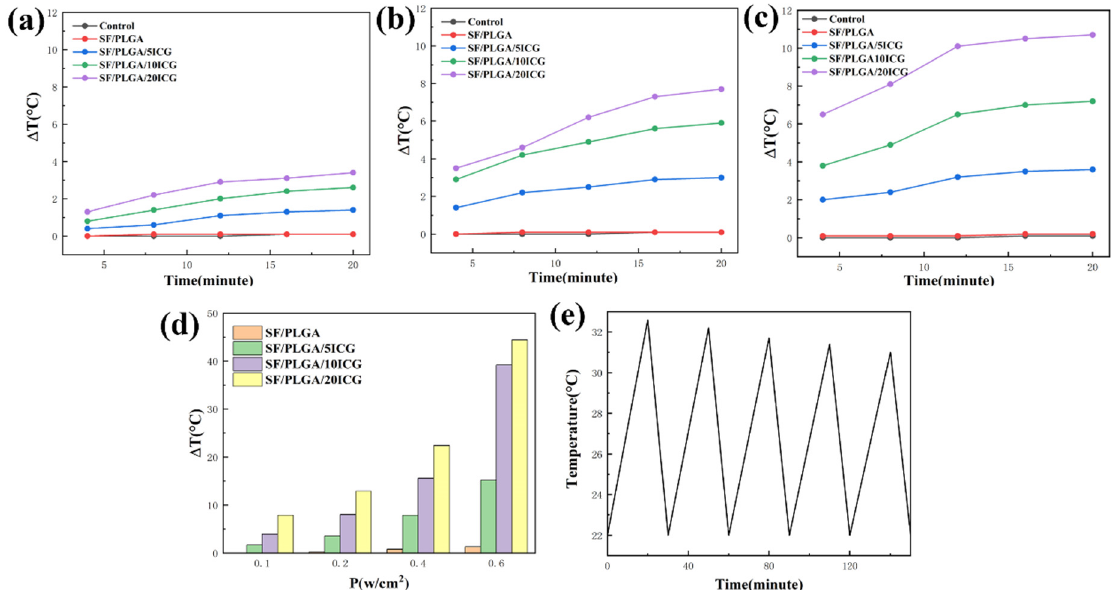
Figure 4. Photothermal performance. Temperature profiles of the nanofibrous membranes in PBS upon NIR irradiation of ( a ) 0.2 w/cm 2 , ( b ) 0.4 w/cm 2 , and ( c ) 0.6 w/cm 2 ; ( d ) temperature elevation in the nanofibrous membranes using NIR with different laser powers; ( e ) temperature variations of SF/PLGA/20ICG exposed to NIR irradiation.